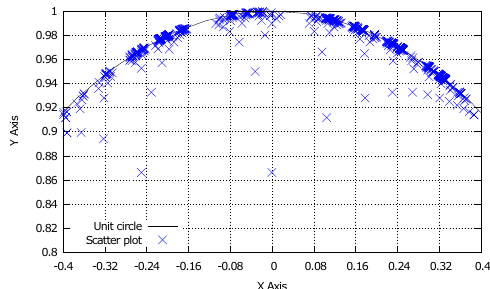
Figure 11. Variation du nombre de stockeur en fonction du nombre de